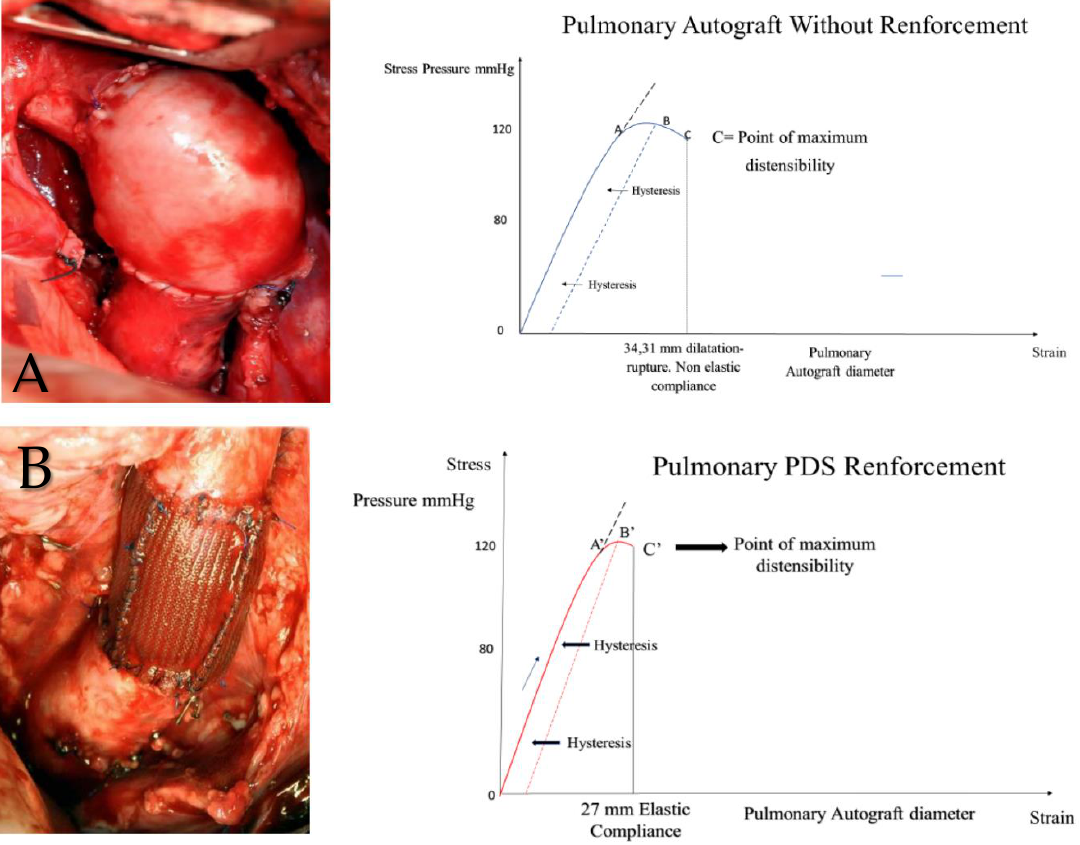
Figure 8. The ability of resorbable hydrogels such as PDF to modify the elastomechanical function of the vessel wall. The application of a bioresorbable reinforcement with the function of hydrogel is able to modify the behavior of the curve of distensible materials as the PA wall, obtaining an increase in their elastic properties. This is observed in the curve as the shift of A ( panel A left) toward A ′ ( panel B left) with increased elasticity and compliance. The maximum distensibility, point C toward C ′ , as the reinforcement effectively prevented massive dilation. This provoked a reduction in the critical area determined by the fall of the curve ( panel B left). The potential elastic energy depended on the extension of the surface and on the composition of the material constituting the cylinder including the intramolecular cohesion forces. We demonstrated histologically that during the re- sorption process of a PDS scaffold applied to the PA ( panel B ), a remodeling process of the vessel wall occurred, resulting in a denser connective architecture of the tunica media with an increase in its elastic component. 6. Biomechanics of Pulmonary Autograft Leaflet and Root: Clinical Application Several studies evaluated the biomechanical properties of leaflets and the arterial root of PAs and native aortas with regards to monoaxial and biaxial circumferential and longitudinal stresses, to whom pulmonary autografts were exposed after transposition in the aortic position and increased pressure stress [28,30,51,52]. Our evidence confirmed the previous study of Carr-White et al. who evaluated the mechanical behavior of PAs after a monoaxial stress test [30] and increased the results published by Horer et al. [35] offering a definitive response with regard to the non-linear behavior between the growth, remodeling, and stress shielding of pulmonary autografts subjected to a high-pressure regime . We learned that PA valve regurgitation occurs at a rate of 40% of individuals 20 years after Ross operations despite the pulmonary valve being free from dysfunction at a rate of 53.5% of individuals [50]. Likewise, evidence from a large clinical series does not defin- itively indicate the preferred treatment strategy to prevent the complication of PA expan- sion. Although many observational studies suggest the benefits of adding external rein- forcement to PAs [13,28,34,37,47,67,78,118,119], there are others that revealed negative or neutral findings [13,30]. We worked on the importance of the biomechanical features of reinforced and non- reinforced PAs [25,28,29], extending the evidence originally published by Horer [35] and subsequently reported by Mookhoek et al. [51,52]. The latter, while confirming the non- linear response to mechanical load in failed pulmonary autografts, on the other hand rec- orded increased compliance and reduced wall stiffness of PAs when compared to native pulmonary arteries, suggesting an explanation for PA dilation [52]. In addition, Mookhoek et al., when comparing failed PA roots to native aortas, disclosed an increased compliance of explanted PA roots with respect to the aorta; however, PAs revealed